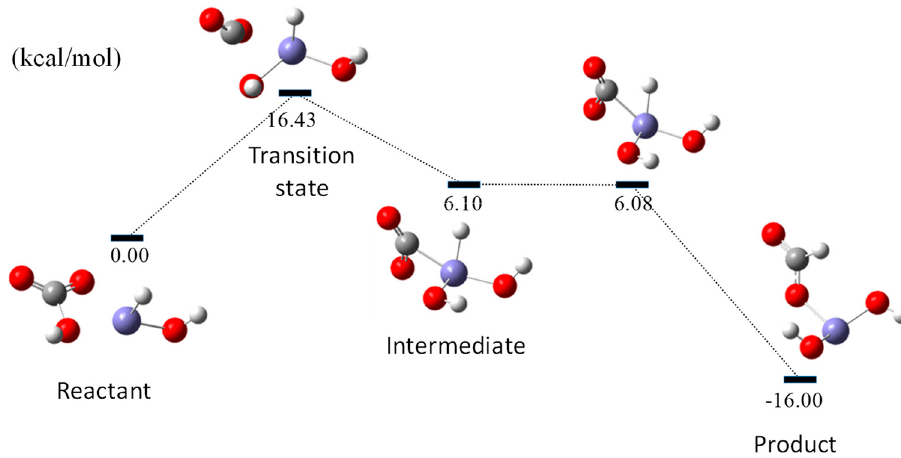
Figure 3. Potential energy diagram for HCOO production.